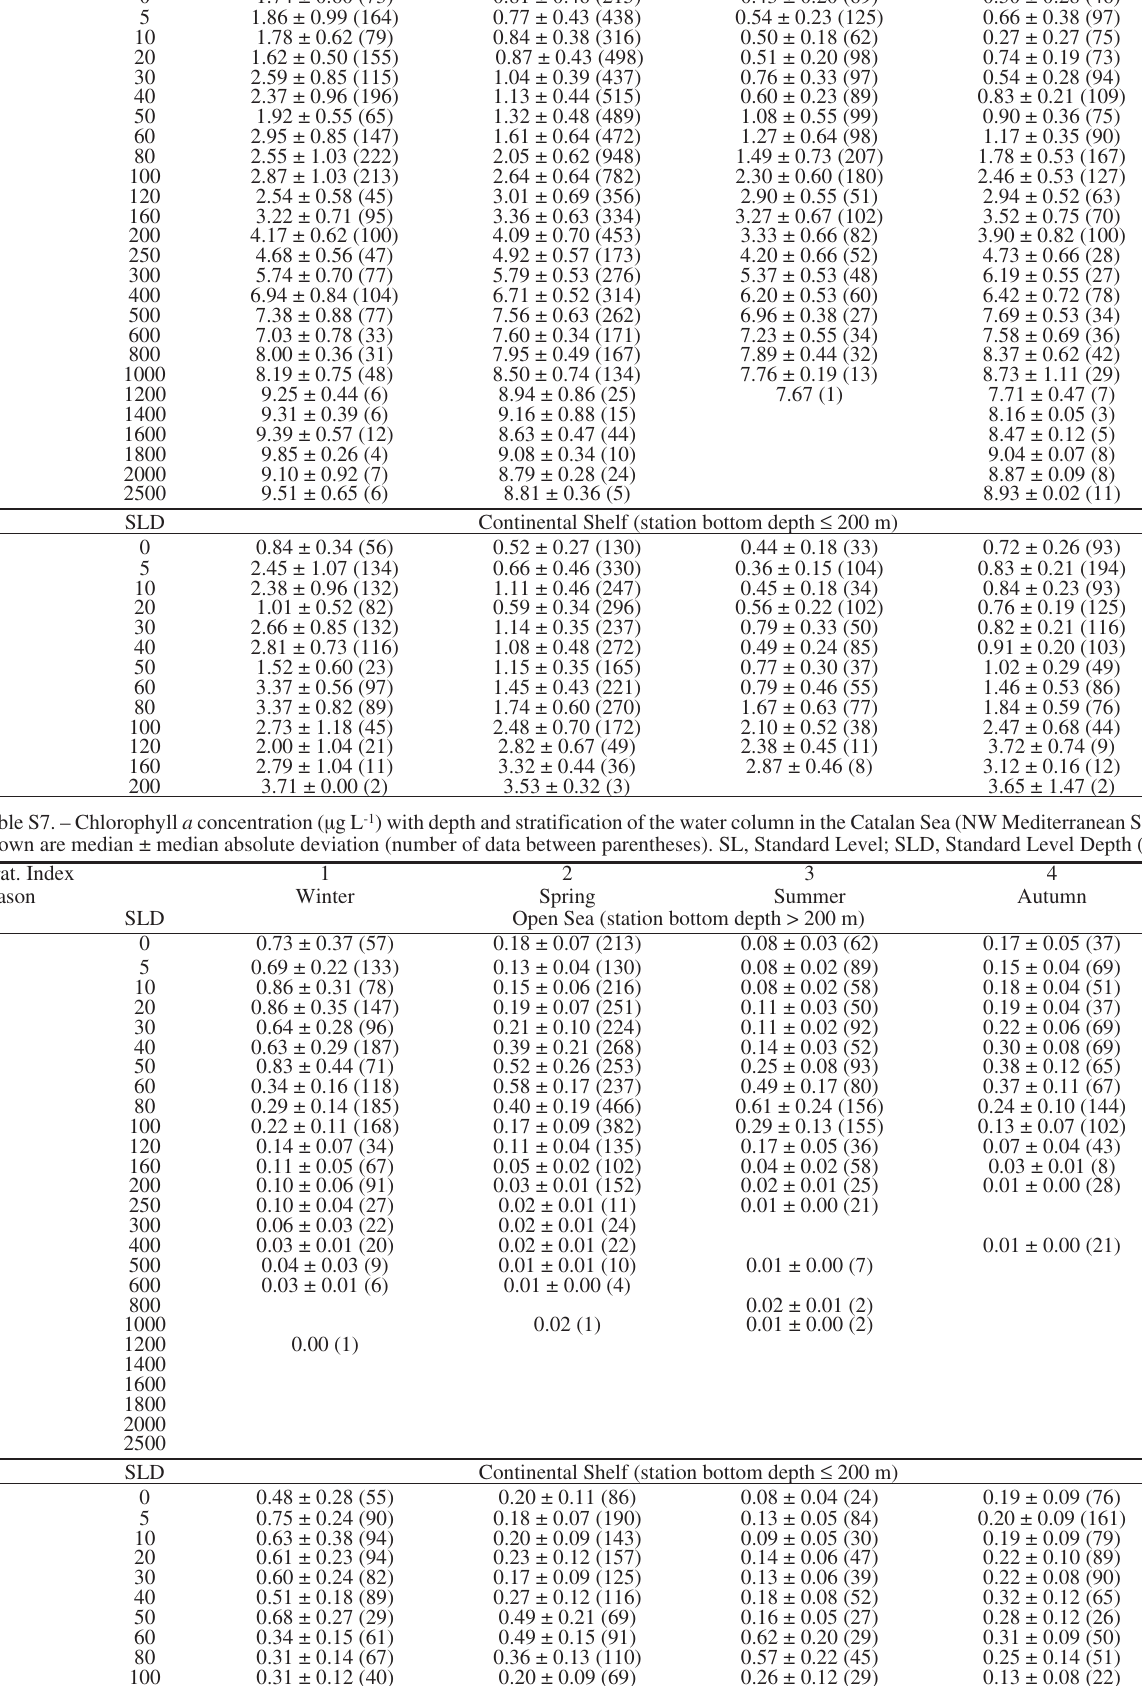
Table S6. – Silicate concentration (μM) with depth and stratification of the water column in the Catalan Sea (NW Mediterranean Sea). Shown are median ± median absolute deviation (number of data between parentheses). S, Standard Level; SLD, Standard Level Depth (m). Strat. Index